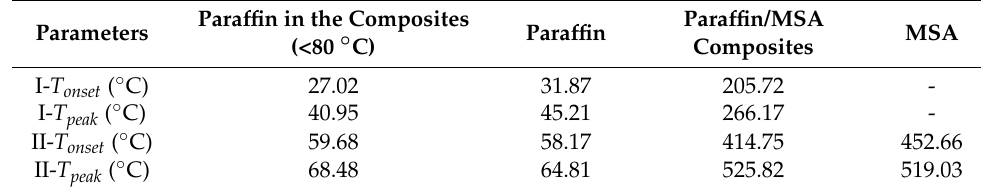
Table 2. Thermal parameters of different thermal processes.